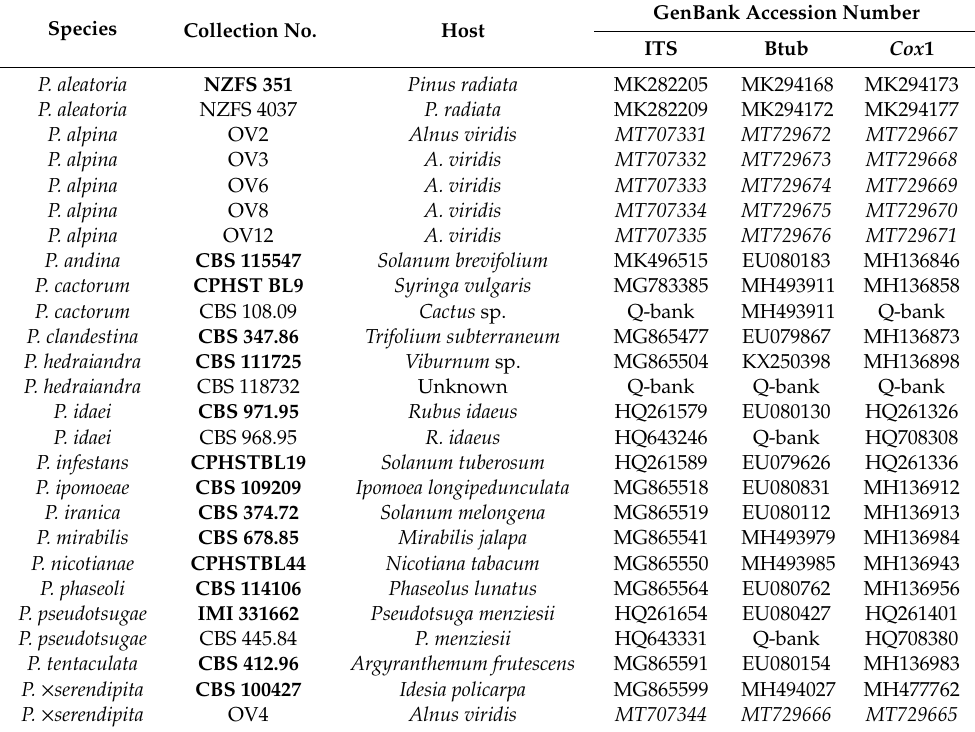
Table 2. Details of Phytophthora isolates belonging to the clade 1 included in the phylogenetic analyses. Ex-type cultures are given in bold typeface and newly generated sequences are indicated in